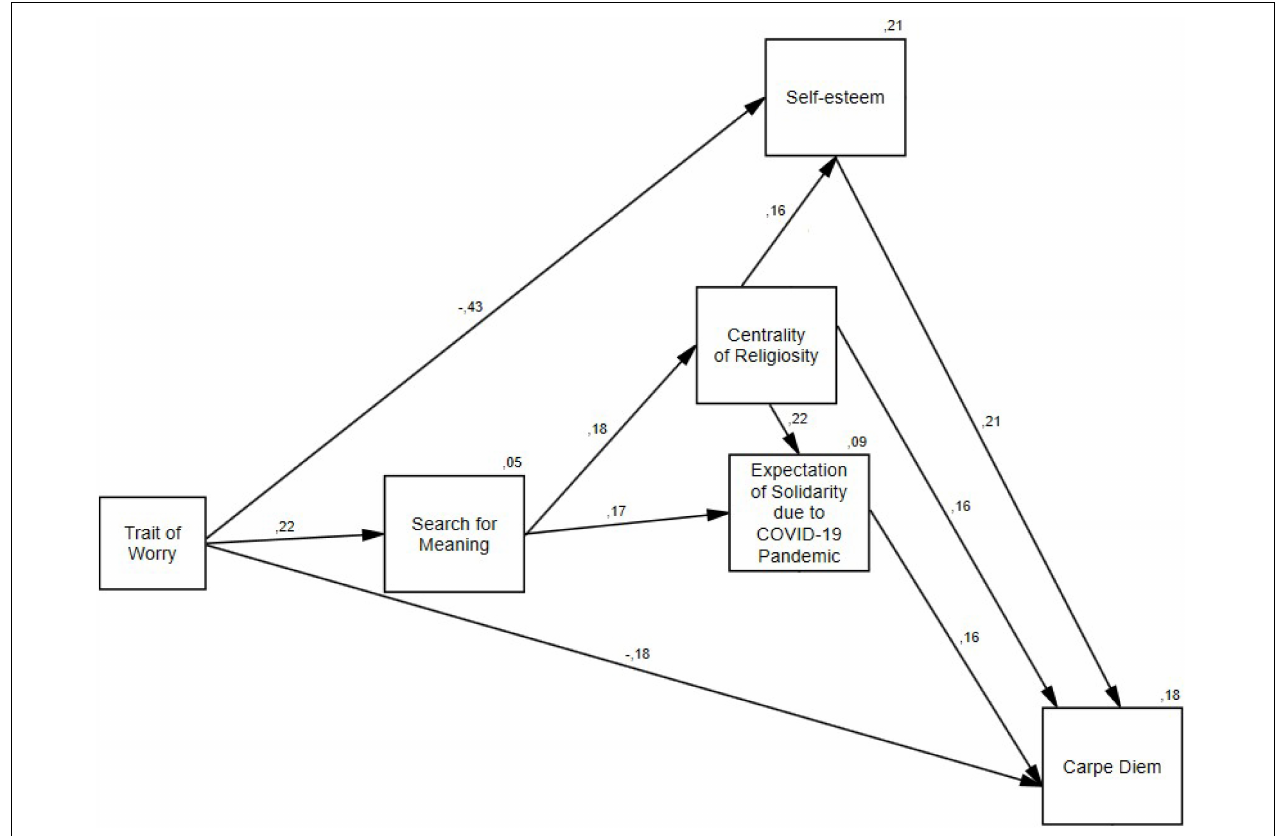
FIGURE 1 | Path model: search for meaning, centrality of religiosity, expectation of solidarity, and self-esteem and carpe diem orientation. N = 295.